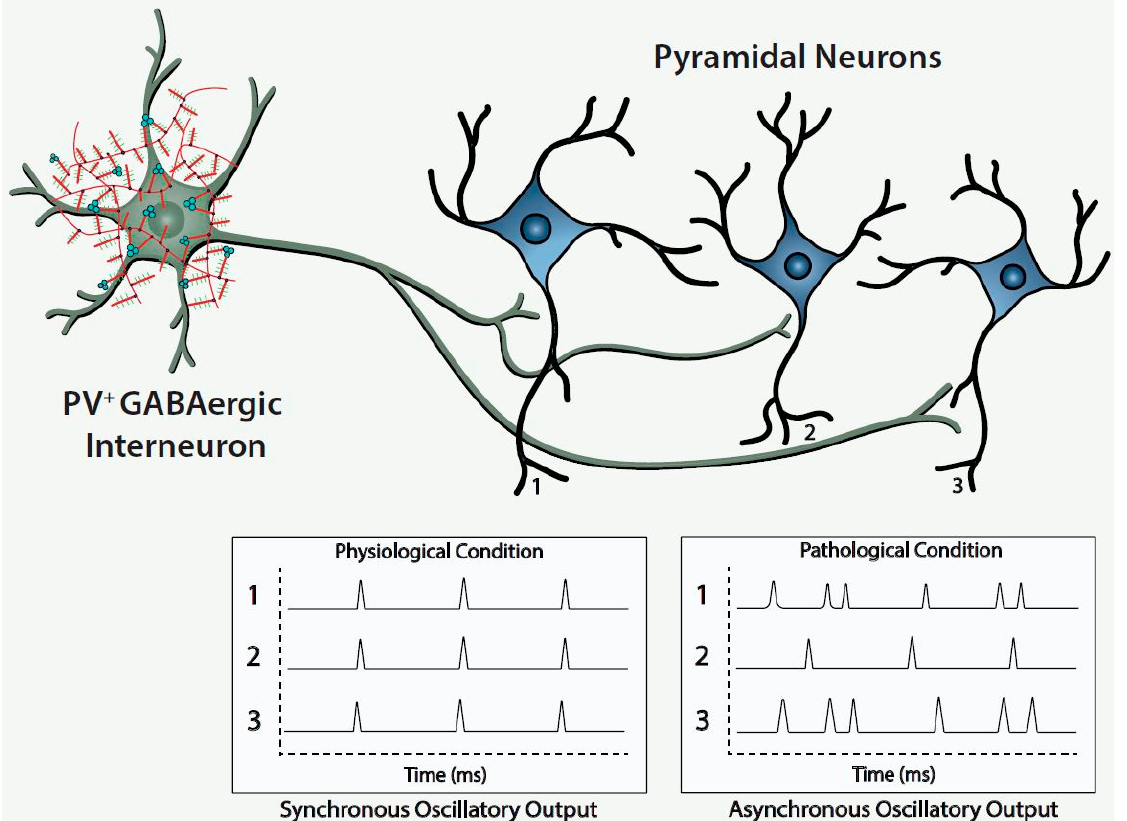
Figure 1. Regulation of synchronous oscillatory activity of pyramidal cell neurons by GABAergic interneurons.